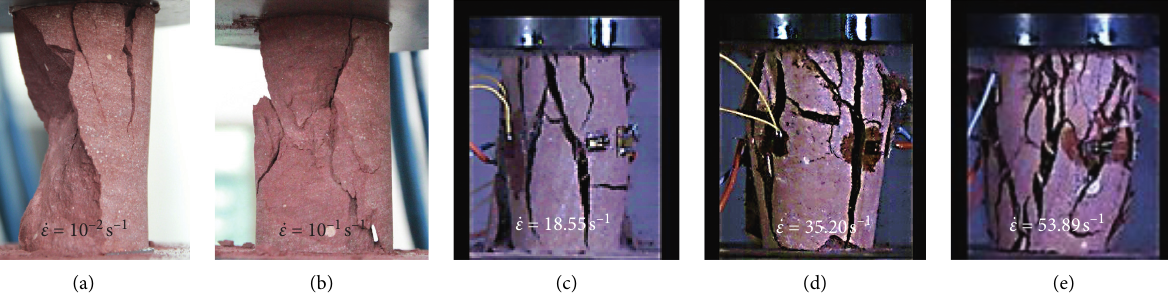
Figure 8: Failure mode of sandstone at different strain rates.